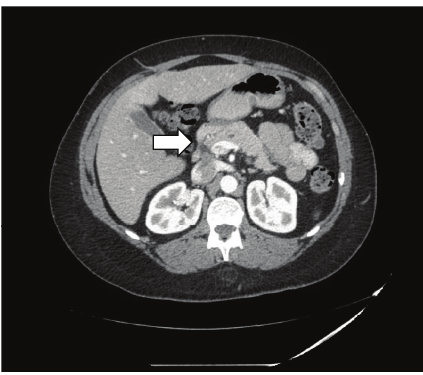
Figure 1: CT scan of the abdomen demonstrate a mass, arising from the uncinate process of the pancreas.